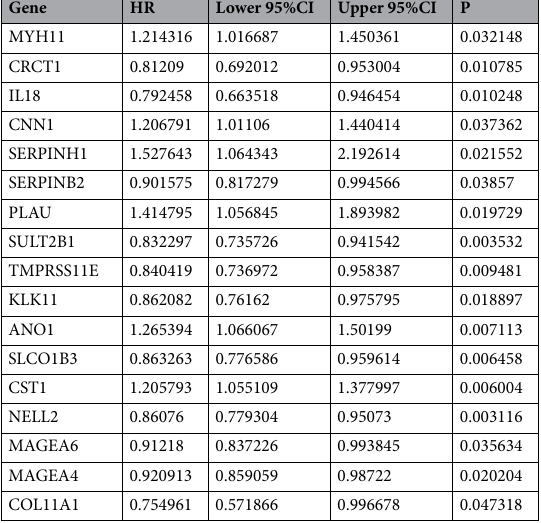
Table 2. Univariate Cox regression analysis of the 17 genes. HR hazard ratio, CI confidence interval.